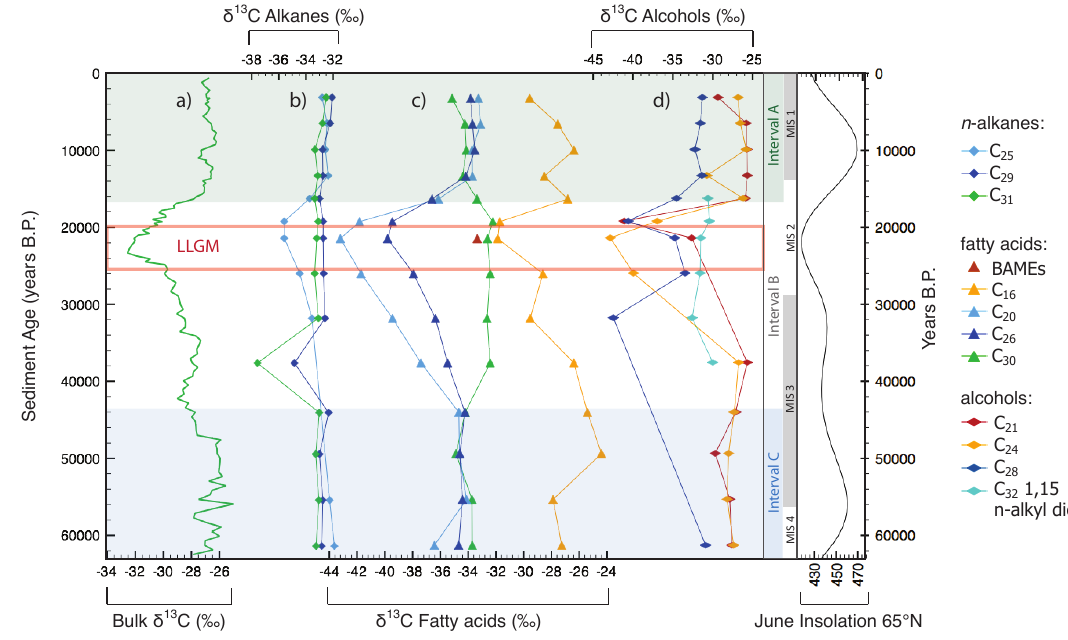
Fig. 3. (a) Bulk and compound-specific δ 13 C values of representative (b) n -alkanes, (c) fatty acids, and (d) n -alkanols. Summer insolation at 65 ◦ N is shown (Berger and Loutre, 1991). The orange box denotes